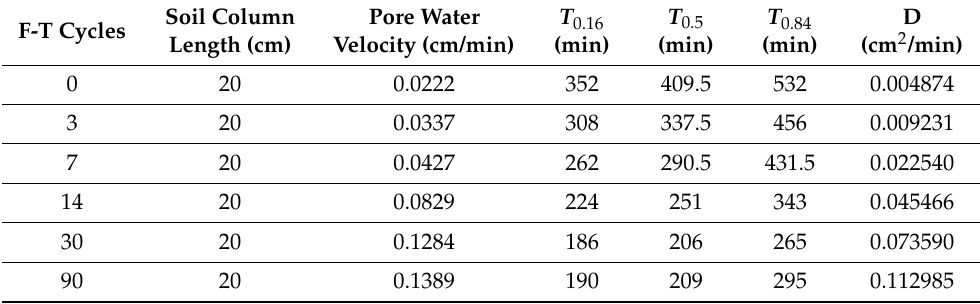
Table 5. Longitudinal migration coefficient (D) under different F-T